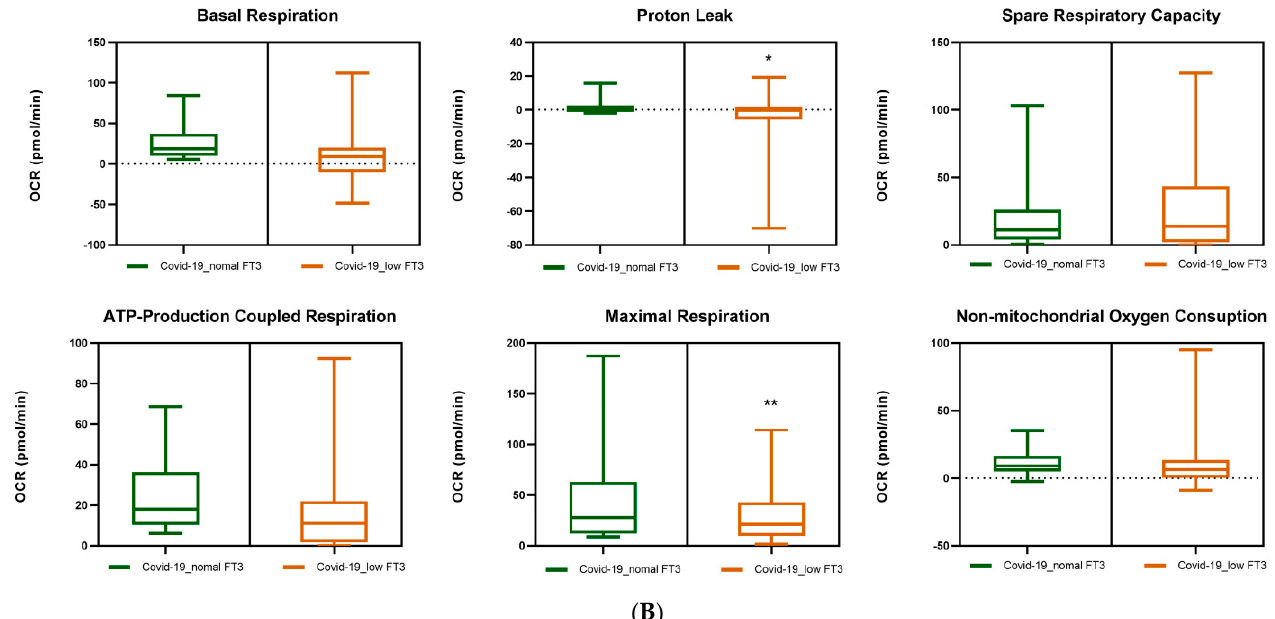
Figure 3. ( A ) Mitochondrial respiration in COVID-19 patients with (upper panel) and w/o (lower panel) NTIS. Traces of OCR of PBMCs from each single COVID-19 patient are reported. ( B ) Mitochondrial respiration in COVID-19 patients with and w/o NTIS. Measurement of basal respiration, proton leak, spare respiratory capacity, ATP-production coupled respiration, maximal respiration, and non-mitochondrial oxygen capacity of PBMCs from COVID-19 patients with and w/o NTIS. Data represent individual values, mean, and standard error of the mean (CTR, n = 12; COVID, n = 13). The Wilcoxon test was used for statistical analysis. Exact p values are reported in the figure. * p < 0.05; ** p < 0.005.